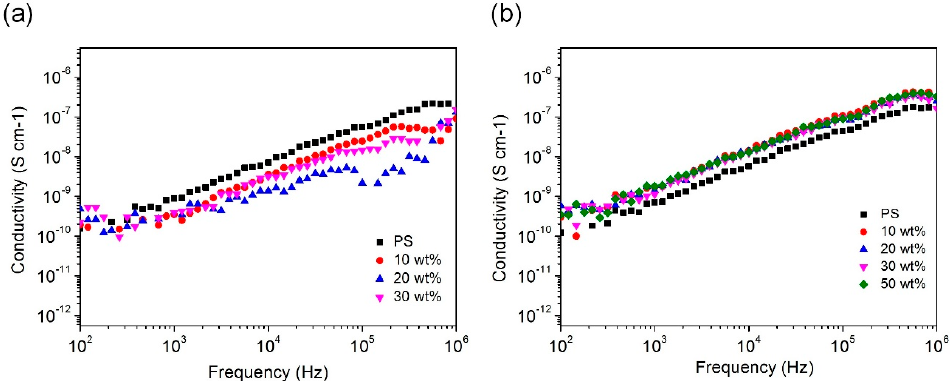
Figure 7. Frequency-dependent electrical conductivity of Al/PS composite films ( a ) PS film doped with agg -Al NPs and ( b ) PS film doped with iso- Al NPs@PS.